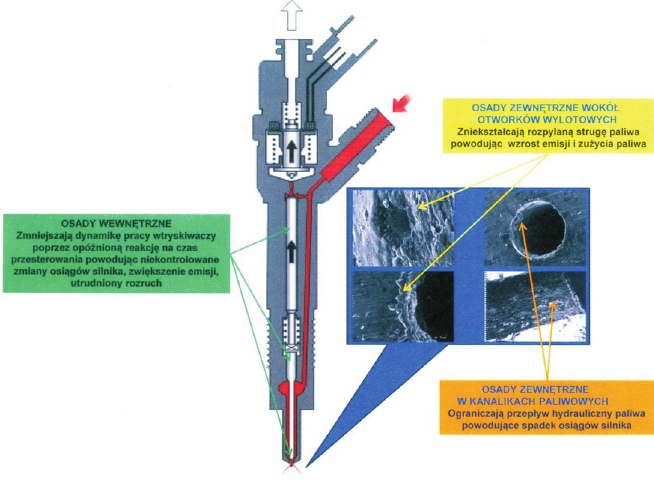
Fig. 3. Areas of occurrence of various types of internal and external deposits on the fuel injectors of high-pressure injection